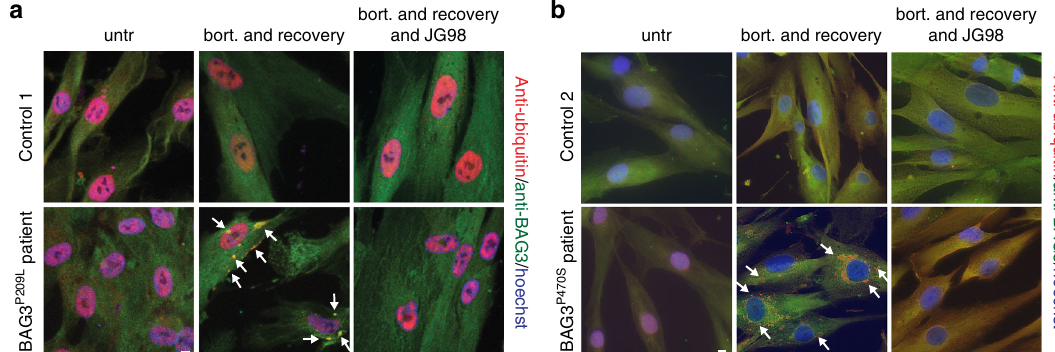
Fig. 9 Abrogation of BAG3 – Hsp70 by pharmaceutical intervention. a , b Immuno fl uorescence pictures using BAG3 (green) and ubiquitin (FK2; red) antibodies of primary control versus BAG3 P209L patient fi broblasts ( a ) or primary control versus BAG3 P470S patient fi broblasts ( b ). Cells were either untreated, treated for 6 h with bortezomib followed by a 20 h recovery or treated for 6 h with bortezomib followed by a 20 h recovery in the presence of 0.05 µ M JG98. Arrows indicate BAG3-punctae. Scale bar = 5 μ m. Source data are provided as a Source data fi le